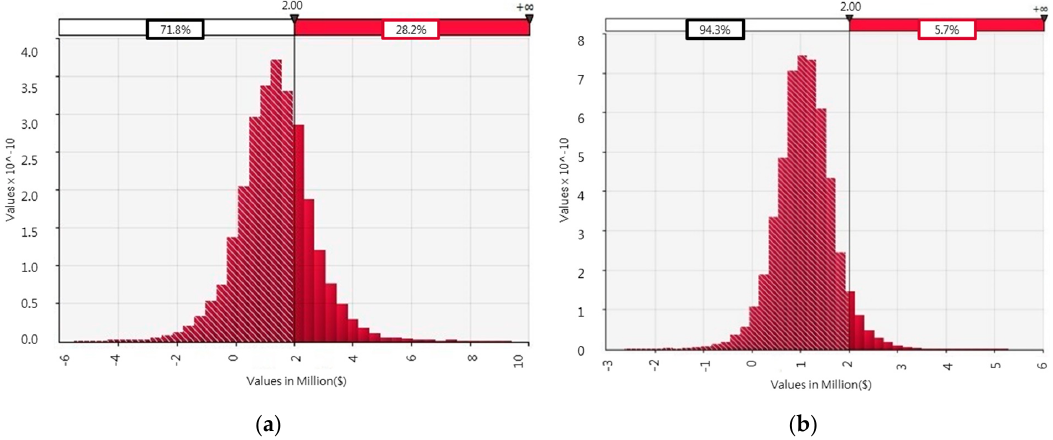
Figure 5. Net present value (NPV) Monte Carlo Analysis ( a ) without SVR and ( b ) with SVR.